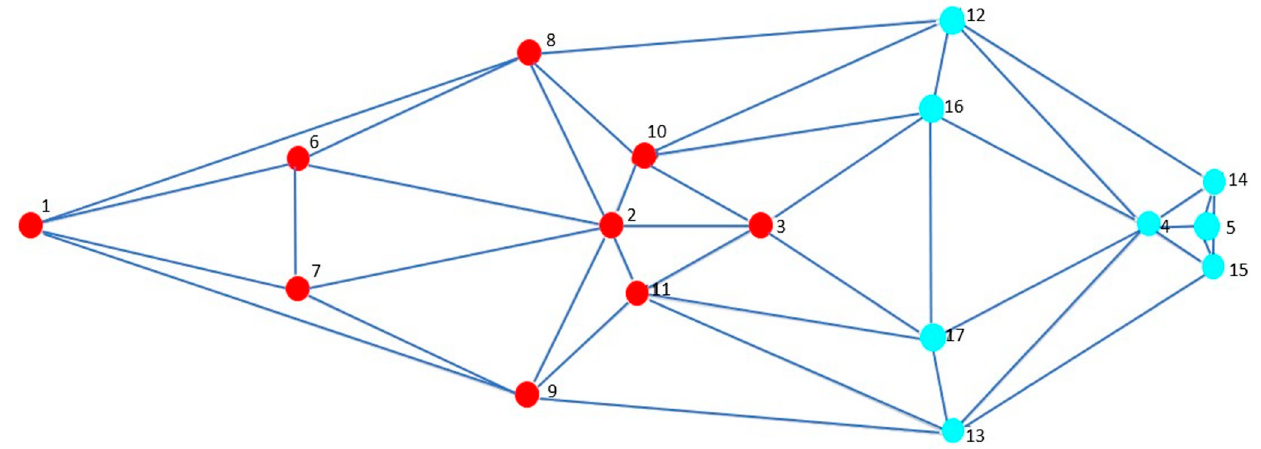
Figure 2. Hypothetical modules considered: splanchnocranium (landmarks 1 to 3, and 6 to 11; red points) and neurocranium (landmarks 4 and 5, and 12 to 17; blue points).